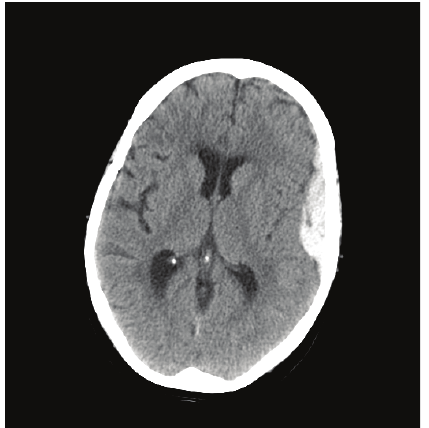
Figure 2: Repeat axial CT head without